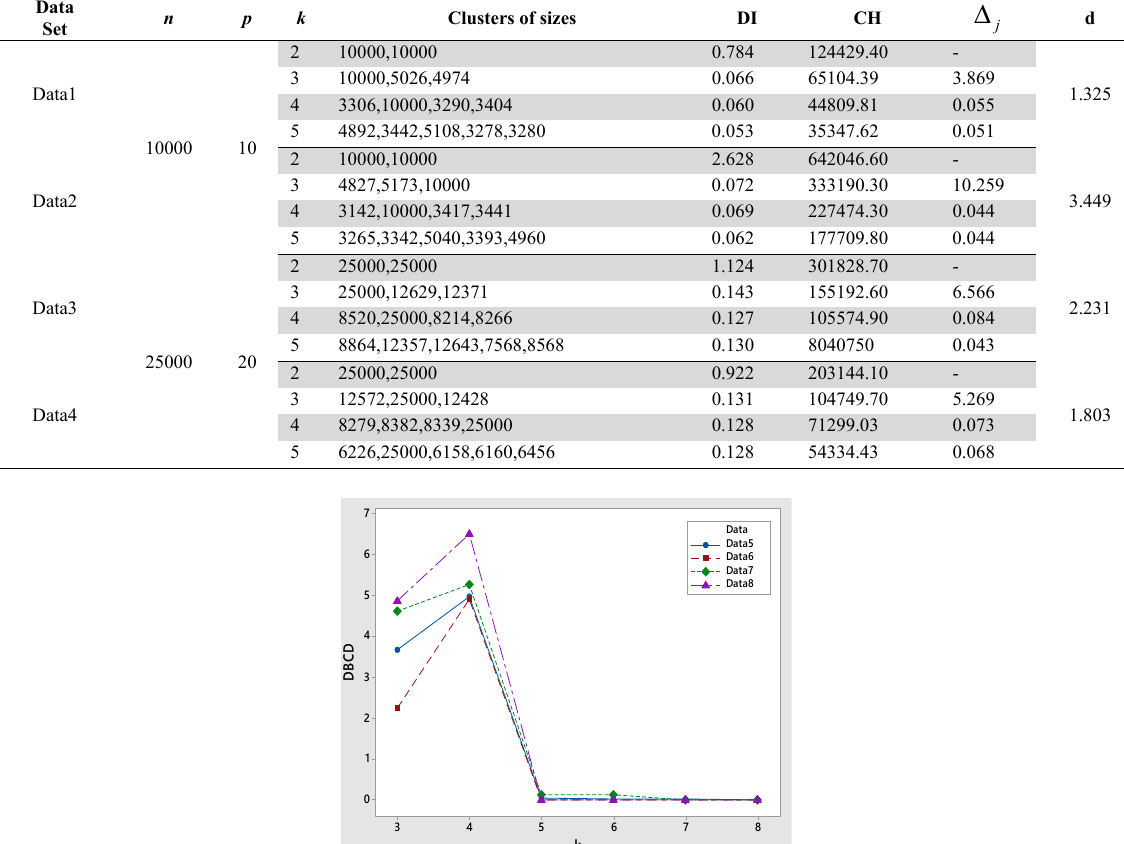
Fig. 4. Scatter plot for distance between cluster centroids (DBCD) vs k for Data1-Data4 Table 1 Clustering results for Data1-Data4 with 2 clusters